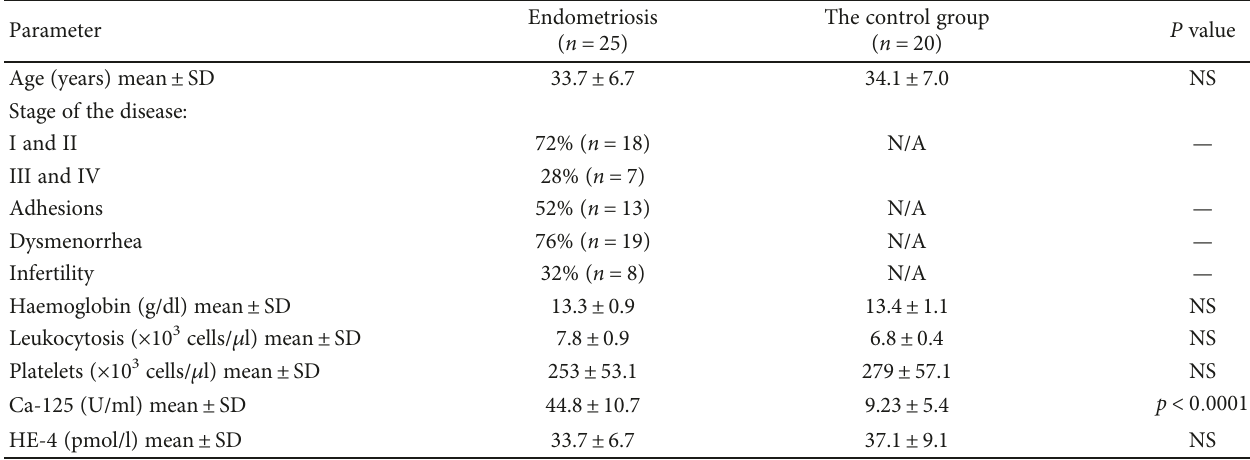
Table 1: Characteristics of the study and the control